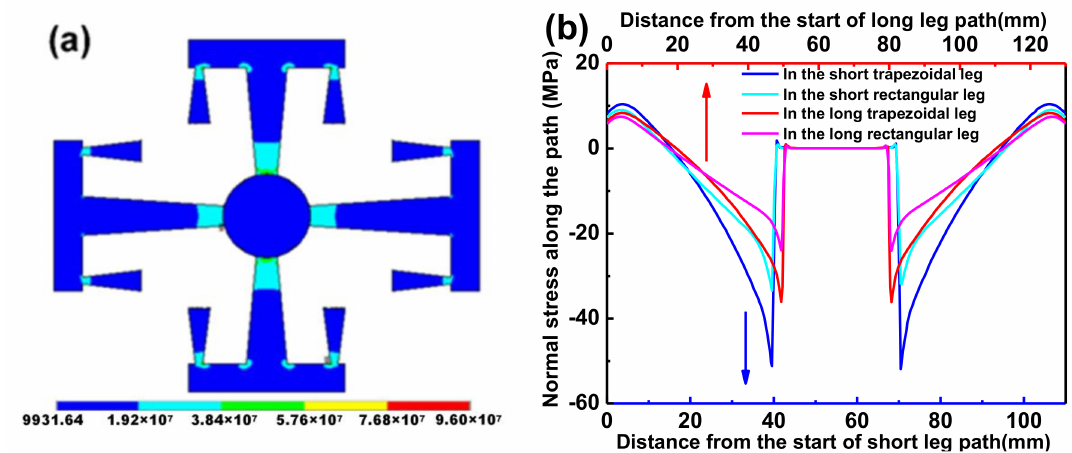
Figure 5. Stress distribution for Case 1: ( a ) von Mises stress and ( b ) normal stress along the leg